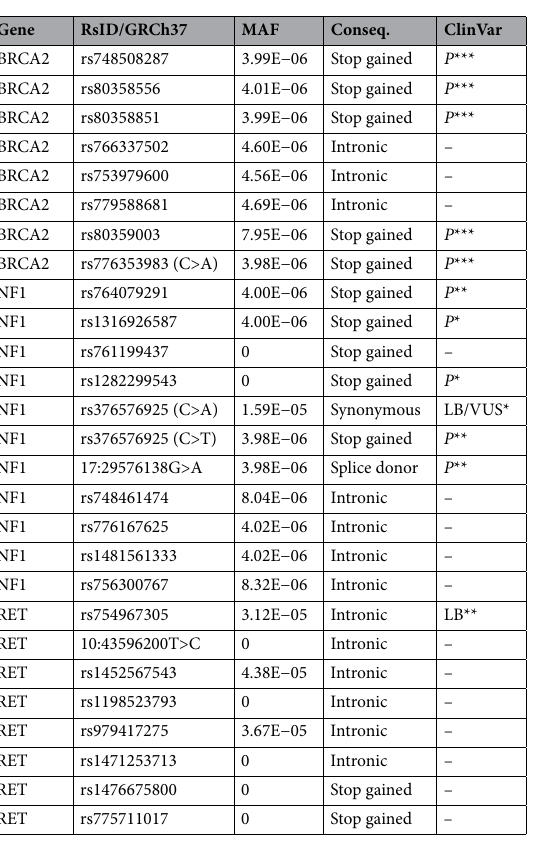
Table 2. GnomAD variants in clinical genes for which the BIOS-trained model predicts ASE effects. The ClinVar classifications shown are: P for Pathogenic, LB for Likely Benign, and VUS for Variant of Unknown Significance. The asterisks indicate the review status of ClinVar, where zero is the worst and four is the best. The MAF (Minor Allele Frequency) values are taken from GnomAD exomes r2.1.1. A MAF of zero means the variant was detected but there were no high-confidence genotype calls made. The RS identifiers are supplemented with base changes in ambiguous cases. GRCh37 coordinates are used if no RS identifiers exist for an